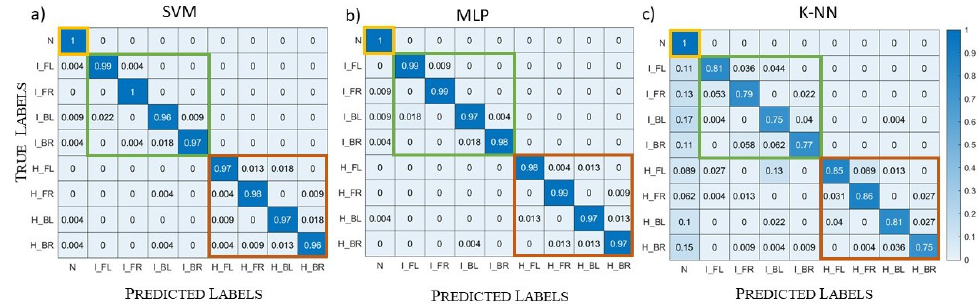
Figure 16. Validation case, complex datasets; normalized confusion matrices: ( a ) SVM results; ( b ) MLP results; ( c ) k-NN